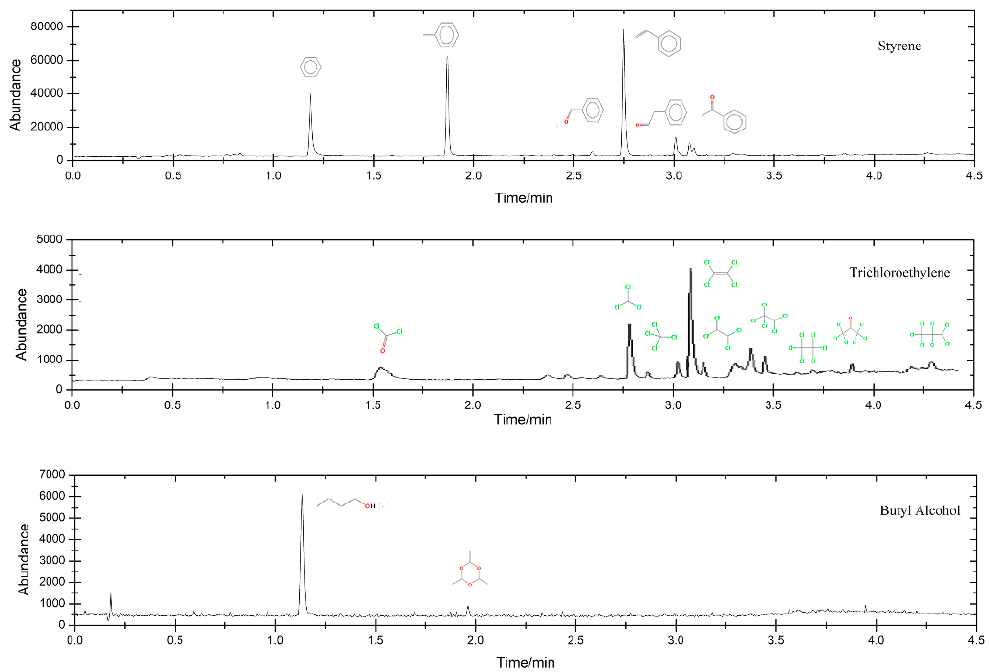
Figure 5. Spectrograms of styrene and butyl alcohol intermediates/byproducts.